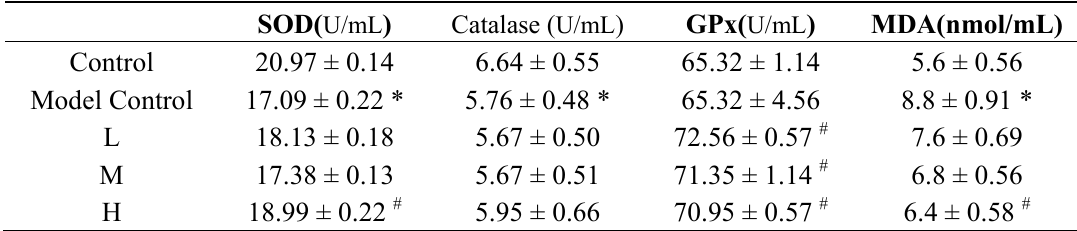
Table 2. Activities of enzymatic antioxidants such as superoxide dismutase (SOD), catalase and Glutathione peroxidase (GPx) and levels of malondialdehyde (MDA) of IEC-6